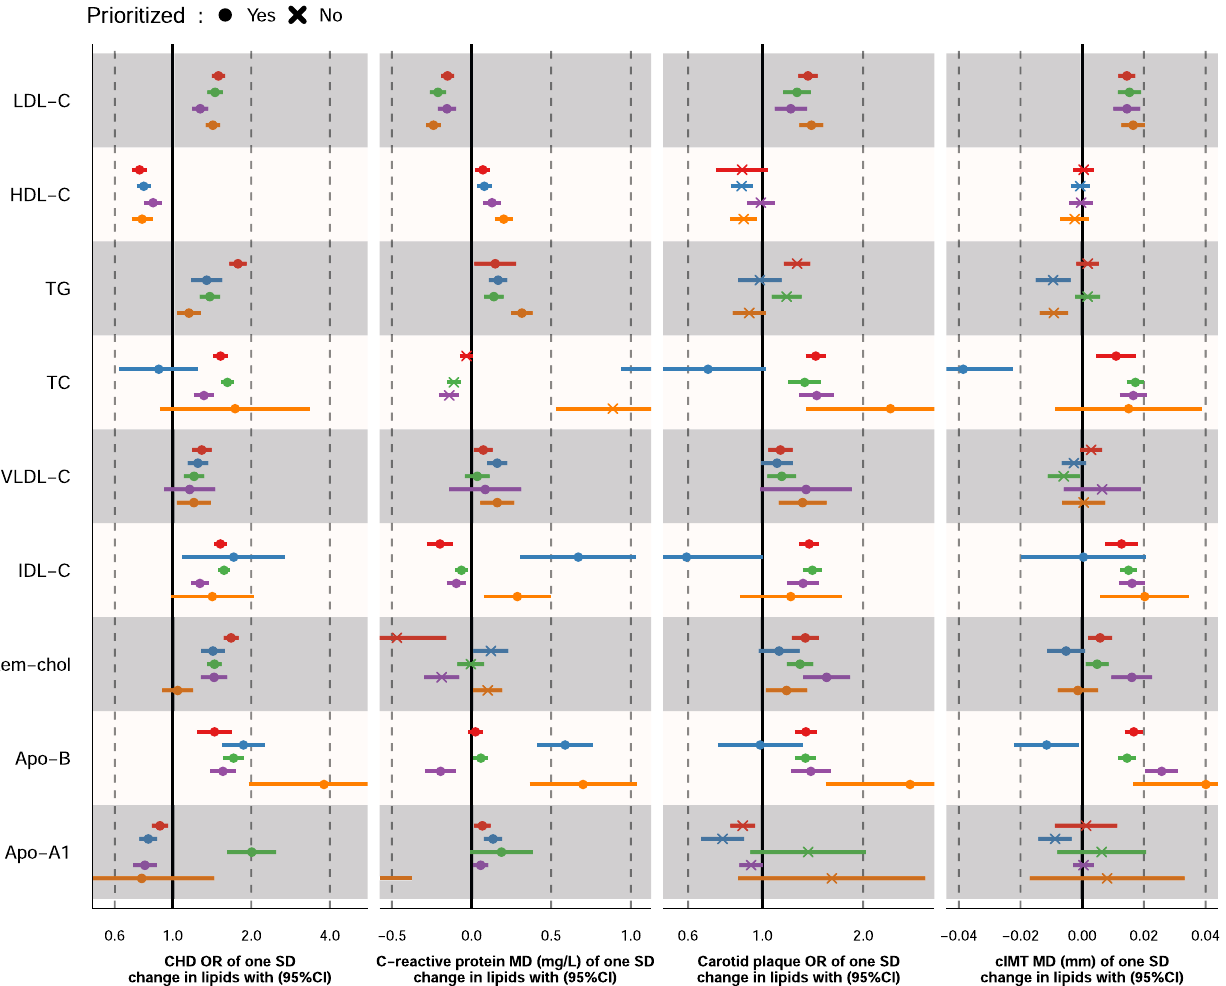
Fig. 4 Mendelian randomization effect estimates of a standard deviation change in cholesterol-containing lipoprotein or apolipoprotein concentration on coronary heart disease (CHD), c-reactive protein (CRP), carotid intima media thickness (cIMT), and carotid plaque. Prioritized results re fl ect associations depicted in the causal network of Fig. 3, where 3 out of 5 (or 4 for LDL-C, HDL-C, and TG) estimates were signi fi cant at an alpha of 0.05 and directionally concordant. Total: the total lipid effect, Conditional effects either, represent the blood lipid effect of LDL-C, HDL-C or TG singularly, or off all three blood lipids in a single multivariable MR (fully adjusted) model. Fully adjusted models for LDL-C, HDL-C, or TG exposures only conditioned on two of the three blood lipids (e.g., the fully conditional model for LDL-C exposure only conditioned on HDL-C and TG). Analyses were based on a 33,029 subject meta-analysis of Kettunen 15 and UCLEB 20 . Estimates are provided as odds ratio (OR) or mean difference (MD) with 95% con fi dence intervals